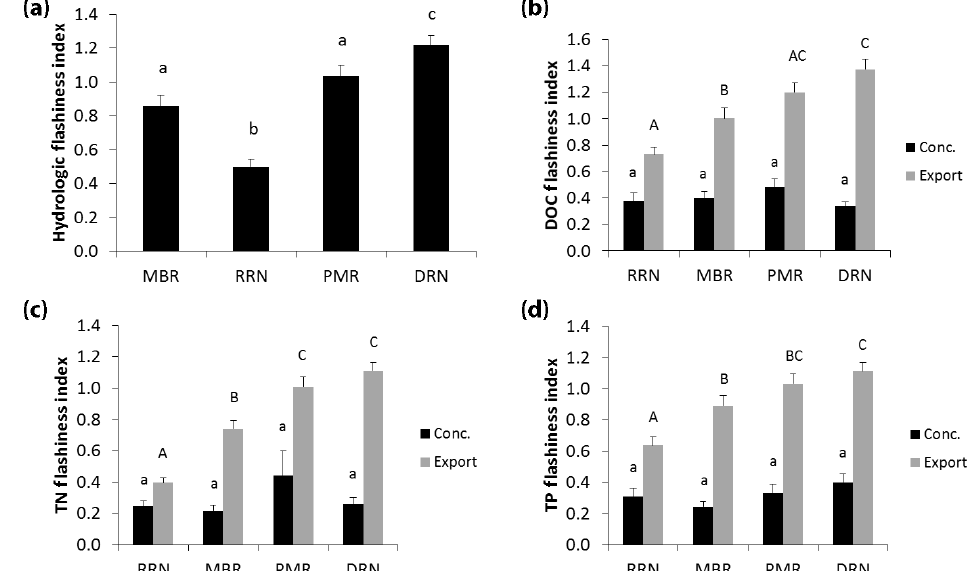
Figure 6. Comparison of the flashiness index for (a) runoff, (b) dissolved organic carbon (DOC) concentration and export, (c) total nitrogen (TN) concentration and export, and (d) total phosphorus (TP) concentration and export. Conc. indicates concentration. Error bars are standard errors of the mean. N = 36, from averaging the monthly flashiness index over 3 years. Flashiness index indicates average change in daily export or routinely sampled concentration per month, divided by the mean monthly export or concentration per